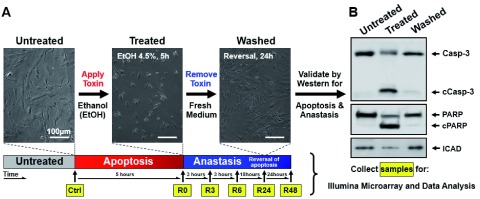
Flow chart for experimental design.Mouse primary liver cells were treated with 4.5% ethanol for 5 hours (R0) and then washed and cultured in fresh medium for 3 (R3), 6 (R6), 24 (R24), and 48 (R48) hours. The untreated cells served as control (Ctrl). (
A) Time-lapse live-cell light microscopy and (
B) Western blot analysis validated apoptosis to occur at R0, and anastasis at R24. Cells were collected at the indicated timepoints of (
A) for RNA extraction. Gene expression profiling was performed by microarray, and analysed by Spotfire. The images from
Figure 1A and B are adopted from the
Mol Biol Cell 23, 2240–52 (2012)
30. Reprinted with permission.